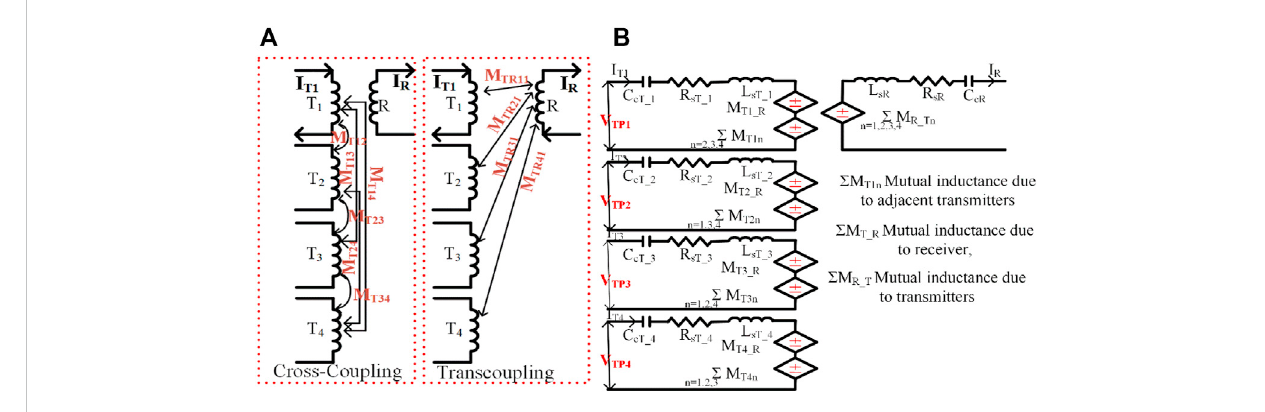
FIGURE 8 (A) Representation of cross-coupling and trans-coupling (B) Equivalent circuit of the compensation